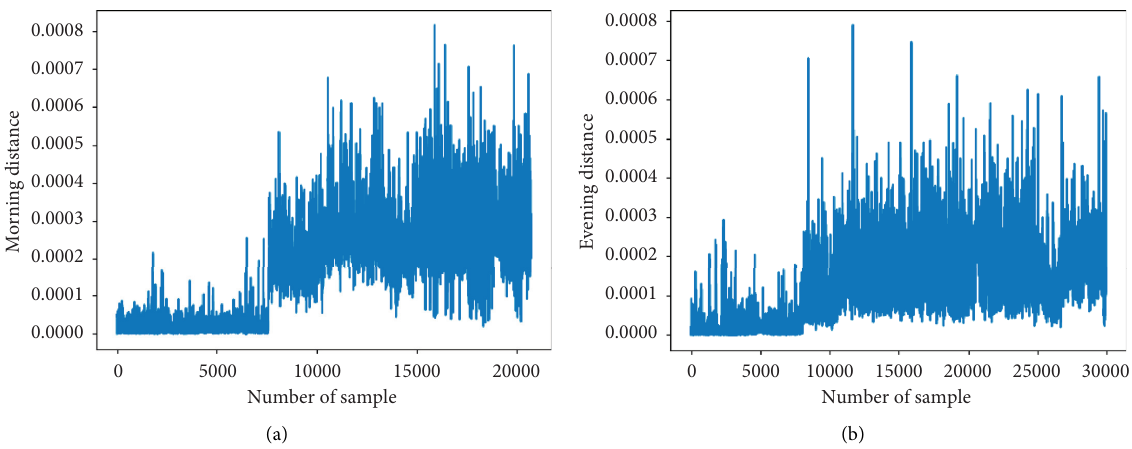
Figure 11: Distance change during peak times: take the first vector in morning and evening peak time as the baseline. The horizontal axis represents the number of samples (a time series). The vertical axis represents the distance between vectors. (a) Distance evolution during morning peak times and (b) distance evolution during evening peak